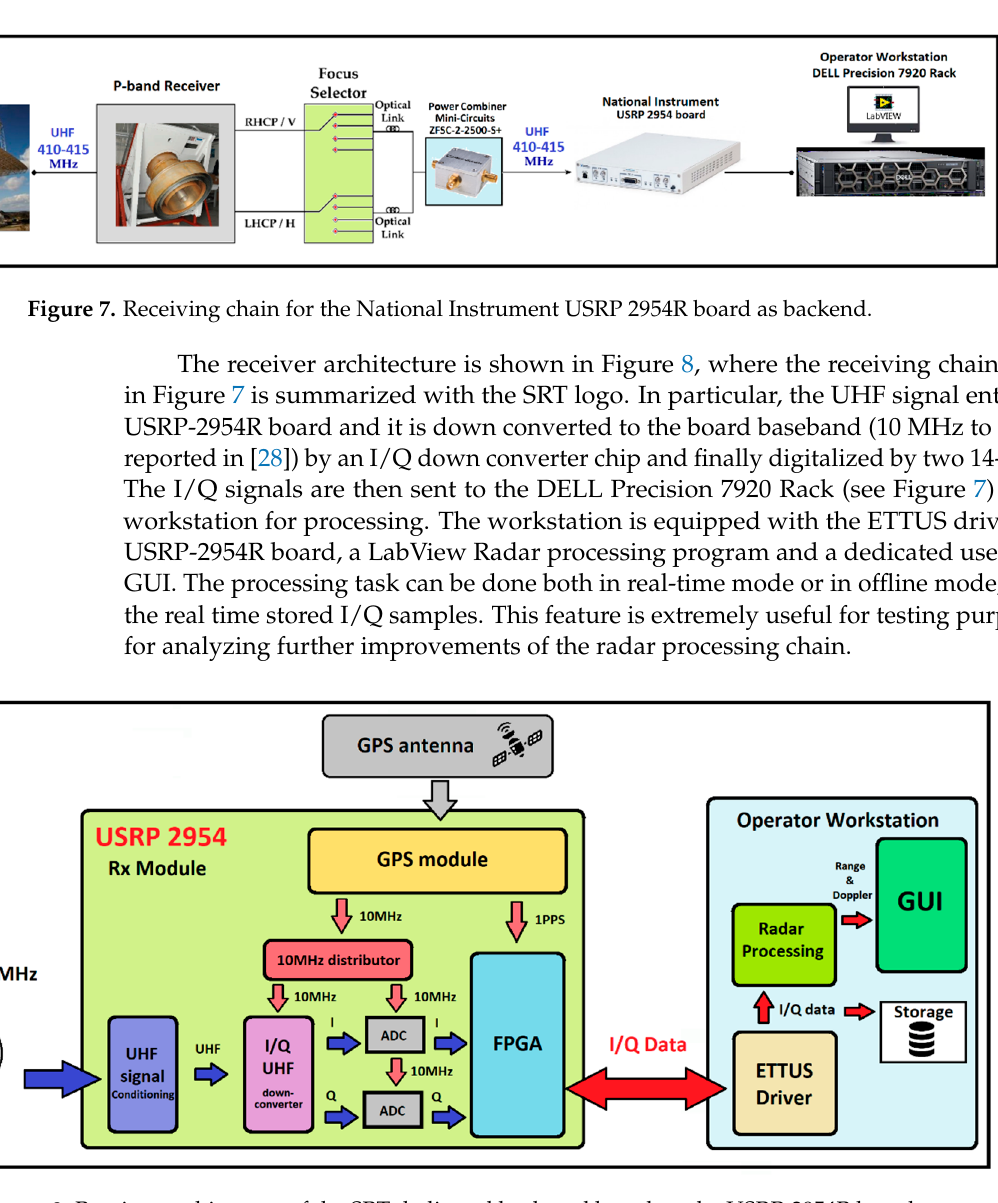
Figure 8. Receiver architecture of the SRT dedicated back-end based on the USRP-2954R board.